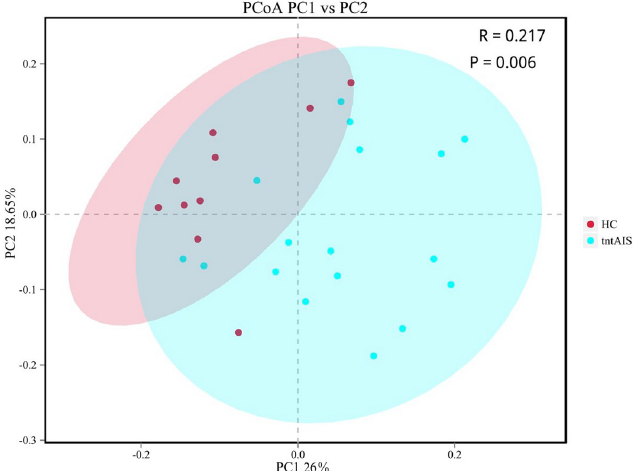
Fig 3. PCoA analysis of the microbiota between HC and tntAIS